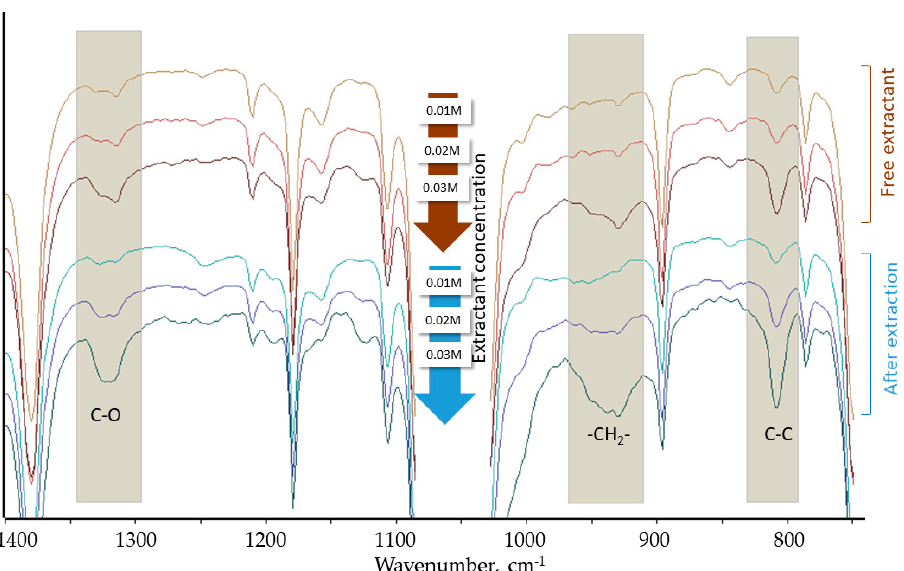
Figure 3. FT-IR spectra of D3EI-PrCl organic phases (0.01, 0.02, and 0.03 M) before and after extraction of Pd(II).